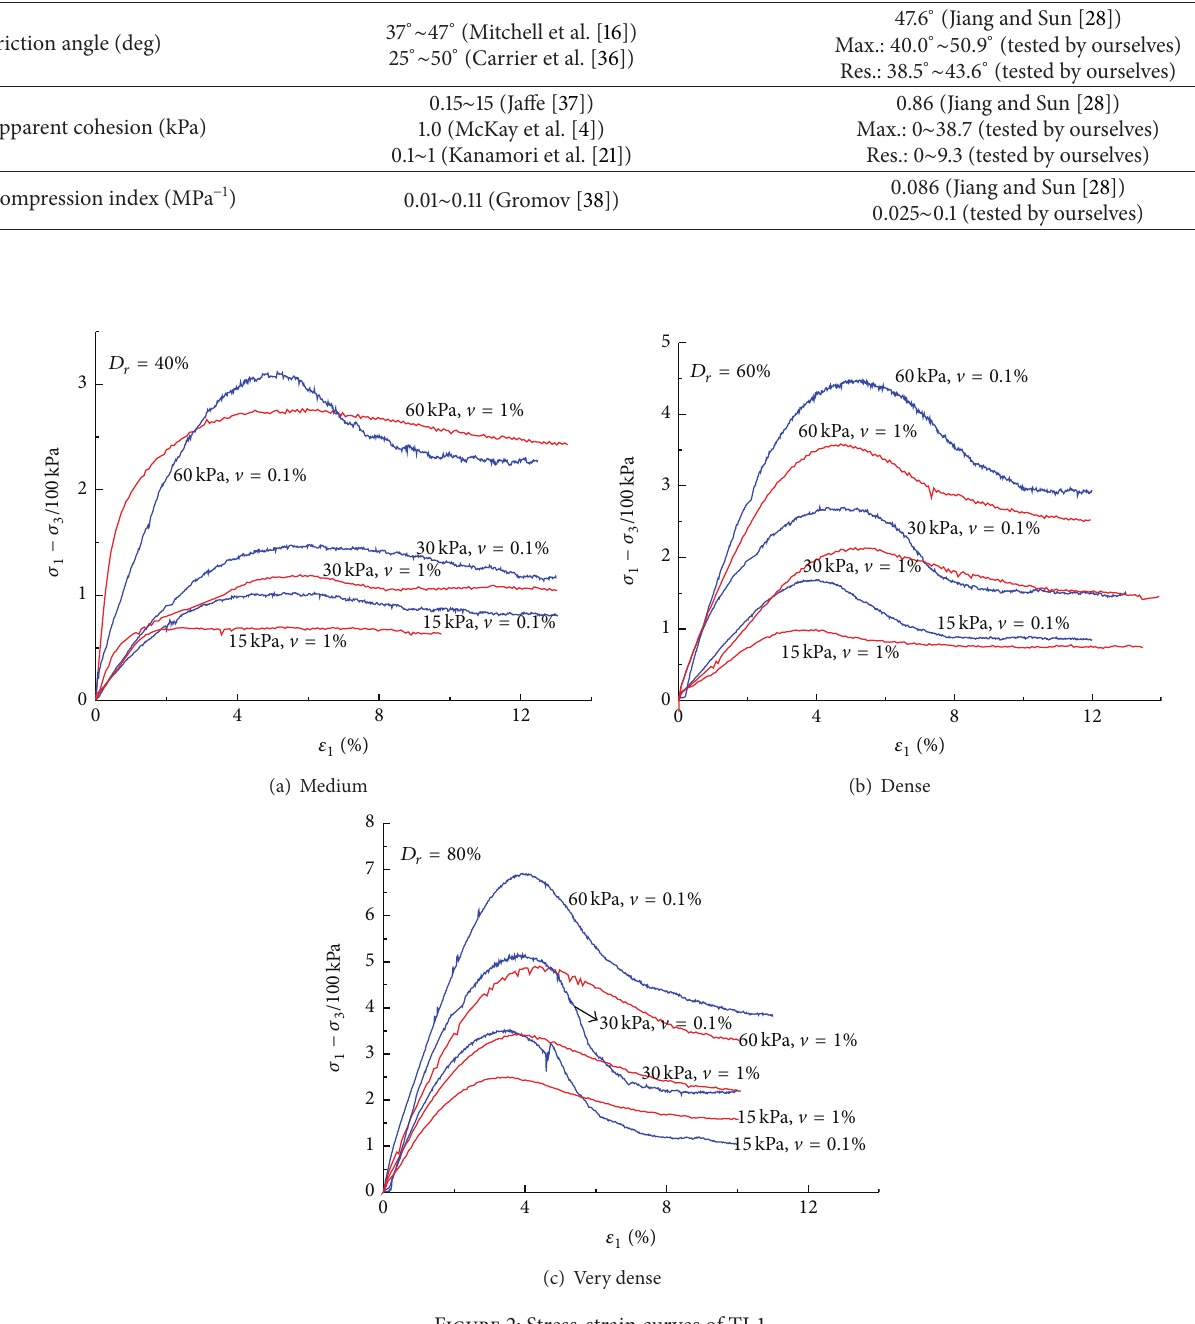
Figure 2: Stress-strain curves of